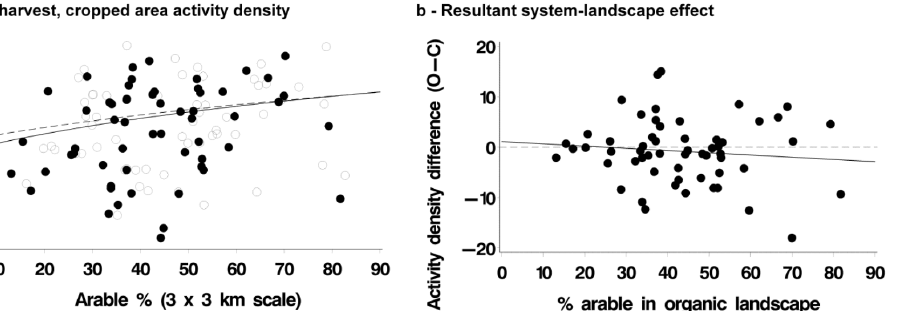
Fig 2. Effects of farming system and landscape on activity density of web-building spiders, no system effect, and one example plotted. Organic: solid lines, filled points; conventional: dotted line, open points. Plot in left hand panel: line in plot is linear regression plotted on log scale by system, points are farms. Plot in right hand panel: line in plot is linear regression (solid line) and reference line (dotted at system difference = zero), points are farm pairs. Right hand panel extracts system effect from left hand panel, O-C difference on arithmetic scale.